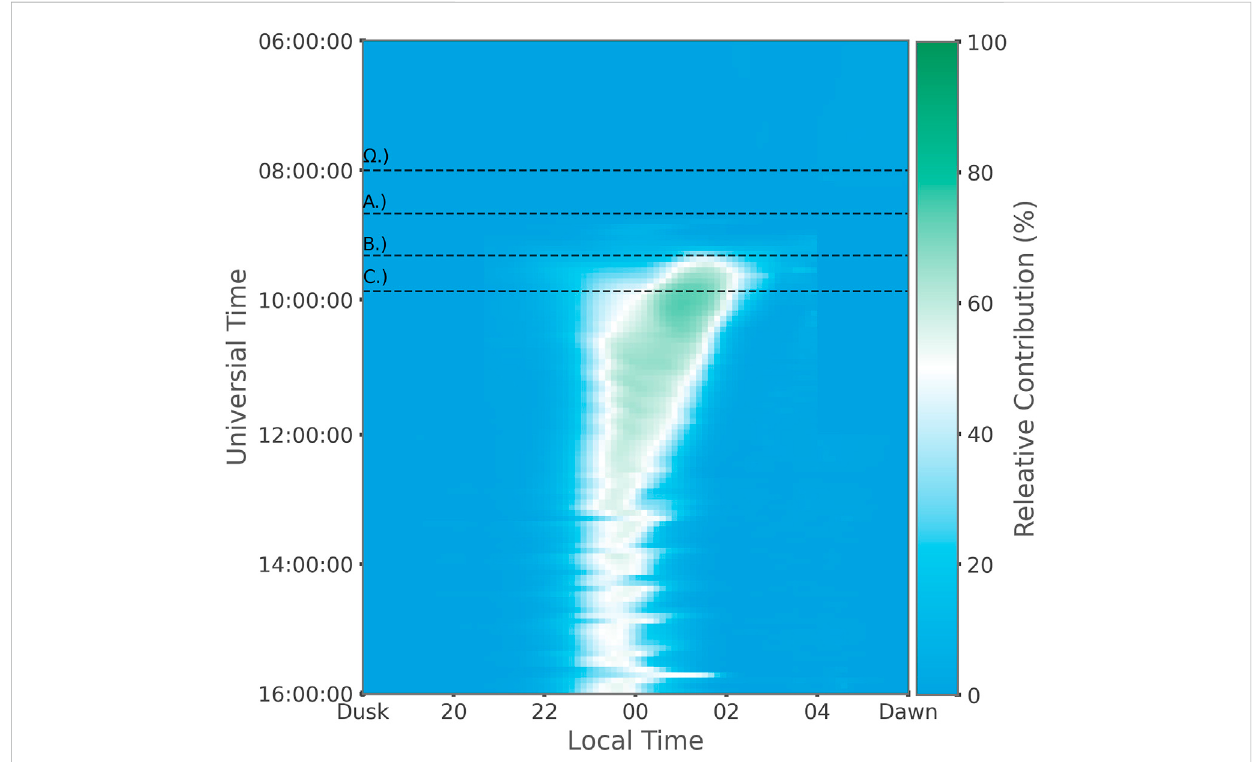
FIGURE 8 Relativecontribution oftherecirculatingplasmasphereas afunctionoflocaltimeand simulationtime.At 0%thereisnorecirculatingplasmaspheric material. At 50% (white) the recirculating plasmaspheric material is contributing equally to the combined contributions of solar and polar winds. At 100% there is no contribution from the solar and polar winds. The horizontal line marked ‘ Ω .) ’ corresponds to the beginning of the storm. The horizontal lines marked ‘ A.) ’ , ‘ B.) ’ , ‘ C.) ’ correspond to the times shown in the left, center, and right columns of Figures three to six